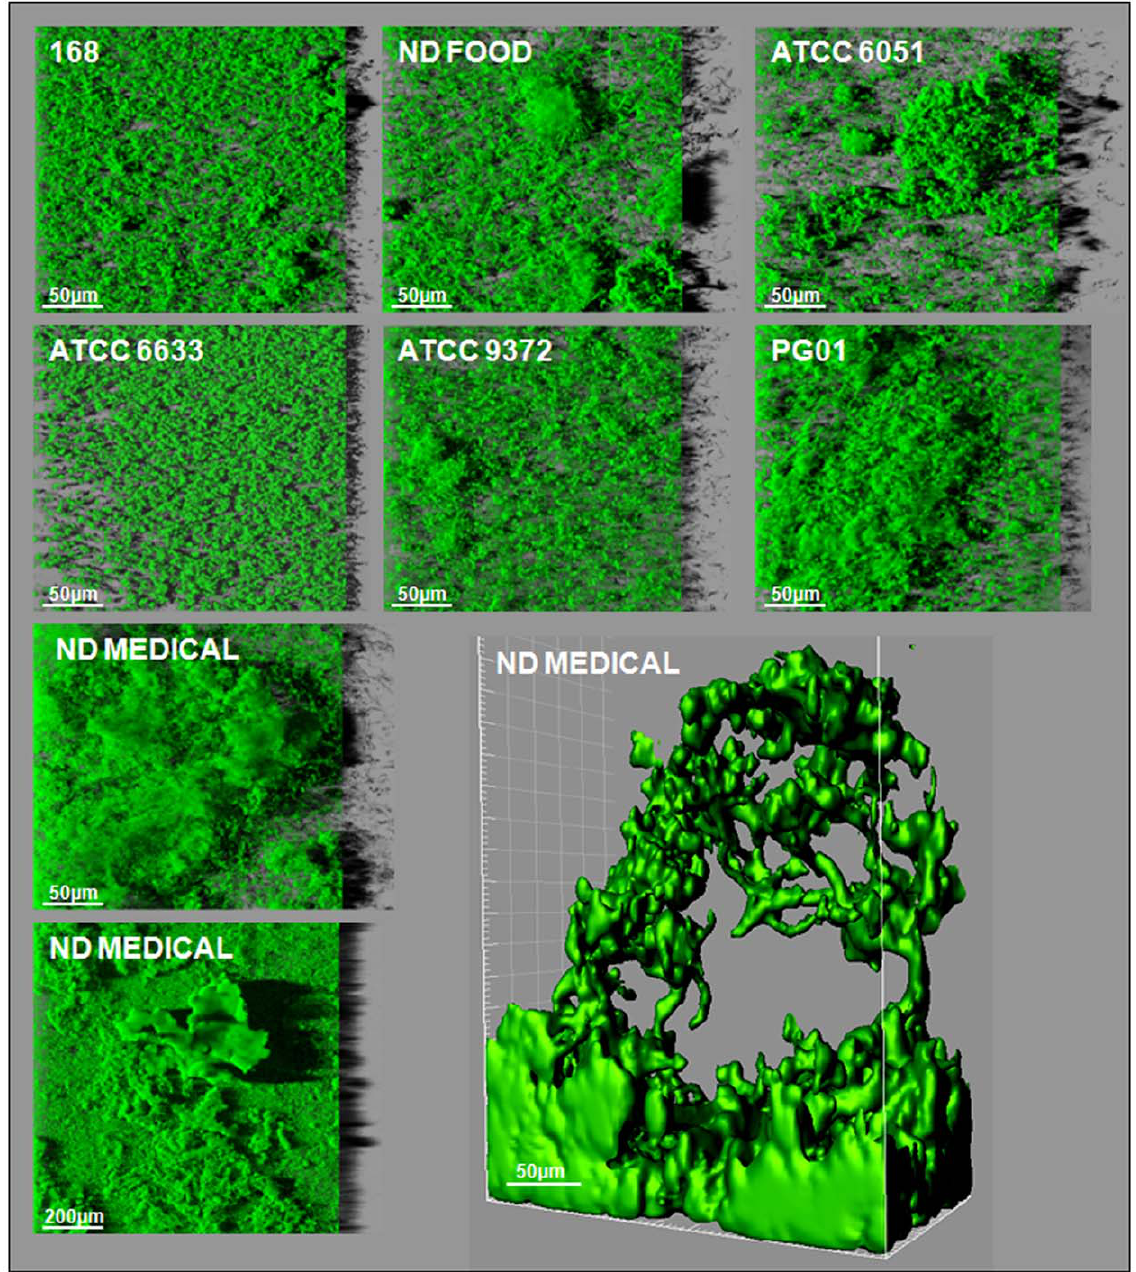
Figure 1. Three-dimensional biofilm structures obtained with the seven B.subtilis strains. These images present a representative, aerial, 3D view of the 48h-biofilm structures obtained with the seven B. subtilis strains using a microplate system, obtained from confocal image series using IMARIS software (including the shadow projection on the right). One iso-surface representation of a particular ‘‘beanstalk-like’’ structure is also shown for B. subtilis ND medical .